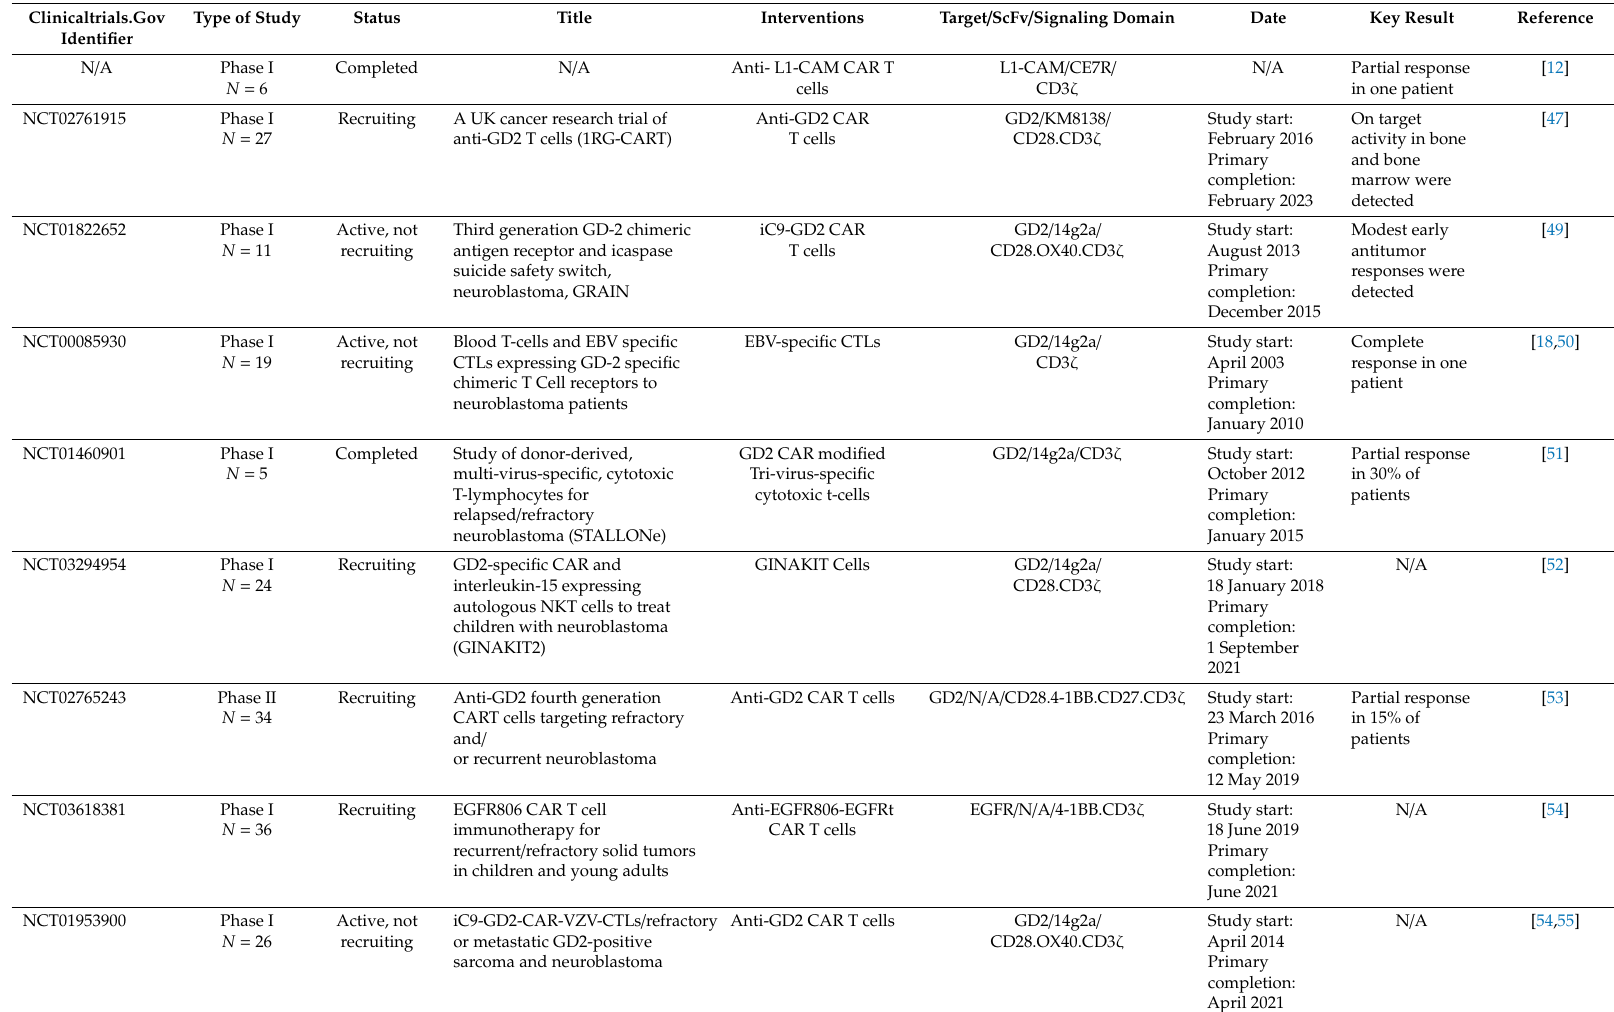
Table 1. An outline of clinical trials for CAR immunotherapy in